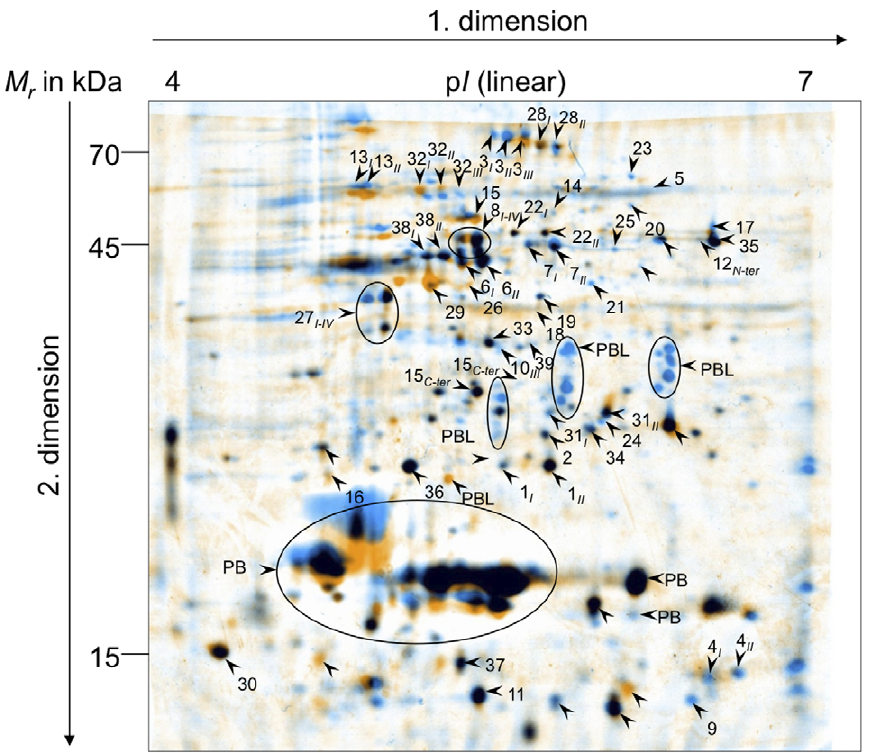
Figure 1. Proteomic comparison of Microcystisaeruginosa PCC 7806 wild type and microcystin-deficient D mcyB mutant. Proteome of soluble fraction of Microcystis aeruginosa PCC 7806 wild type (WT, blue colouring) and microcystin-deficient D mcyB mutant (orange colouring) after exposition to high light of 70 m mol photons m 2 2 s 2 1 for 2 hours. Gels were obtained after separation of soluble protein extracts (400 m g) by 2-DE (first dimension: IEF pH range 4–7 linear, second dimension: SDS-PAGE applying 12.5% acrylamide) and Coomassie-staining. Representative well resolved gels of WT and D mcyB were grouped, respectively, warped and fused to one gel via Delta2D version 4.0 (DECODON, Greifswald, Germany). Differential protein spots and selected non-differential protein spots analyzed for standardization are indicated with arrows. Highly abundant phycobiliproteins (PB), associated linker proteins (PBL) as well as proteins of more than three isoforms are encircled. Protein identities are given in Table 1 and Table S1.